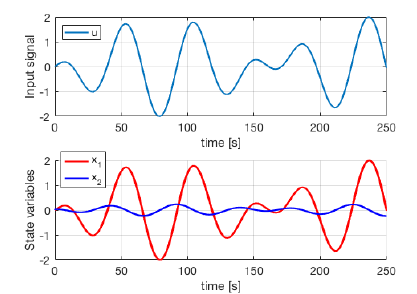
Figure 2. Test input signal and state variables x 1 ( t ) and x 2 ( t ) for the healthy actuator response (with x 1 ( 0 ) = 0 and x 2 ( 0 ) = 0).